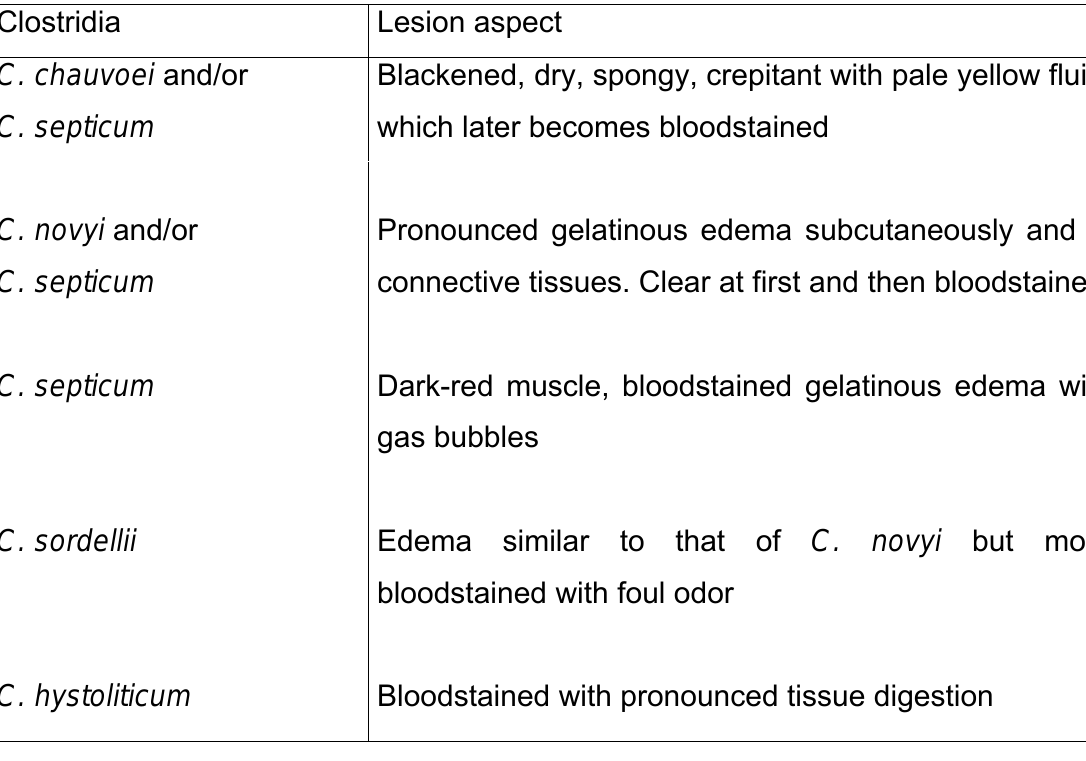
Table 3: Clostridia and pathology of lesions of cattle myonecrosis